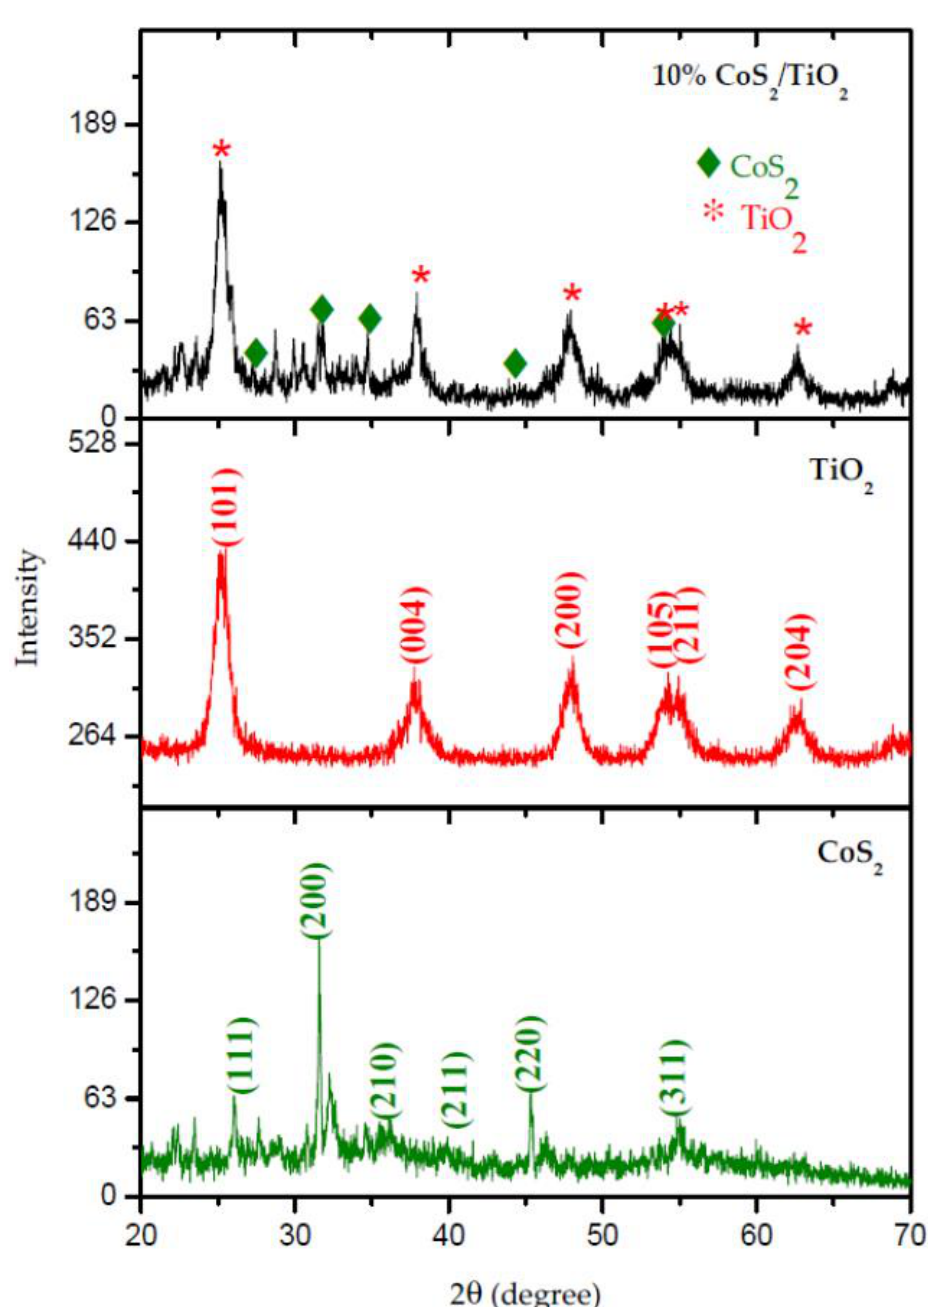
Figure 16. XRD pattern of pure CoS 2 , pure TiO 2 , and 10 wt. % of the CoS 2 /TiO 2 nanocomposite. Reproduced with permission from